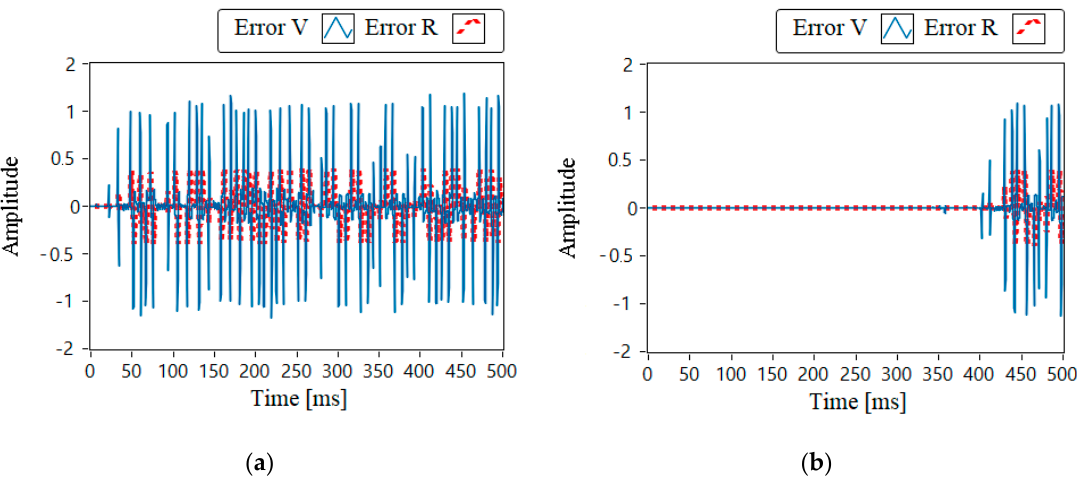
Figure 3. The absolute error of ( a ) 32-bit FXP and ( b ) 64-bit FXP models compared with that of the DBL model in the case of long simulation time.